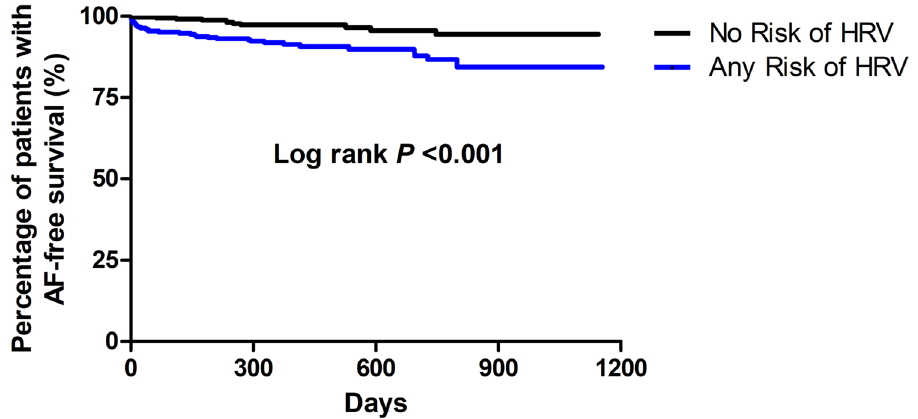
Figure 3. Kaplan–Meier estimate of AF-free survival according to the presence of any risk of HRV. AF, atrial fibrillation; HRV, heart rate variability. Any risk of HRV meant that at least one of the abnormal HRV parameters (HF, rMSSD, and pNN50) were present. AF, atrial fibrillation; HRV, heart rate variability.